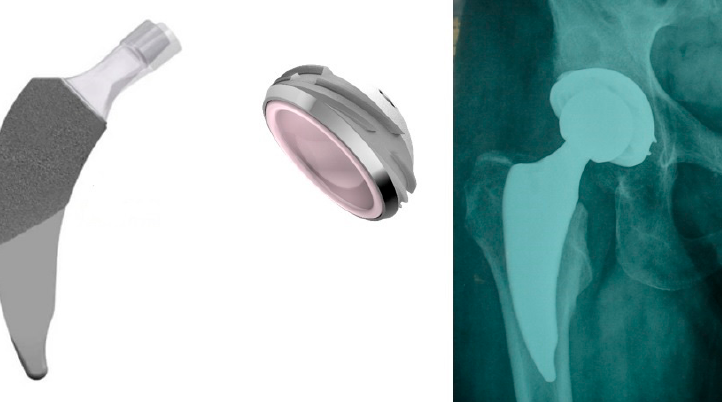
Figure 1. The MINIMA S stem coupled and the DELTA ST-C cup, along with a postoperative anterior-posterior X-ray view.